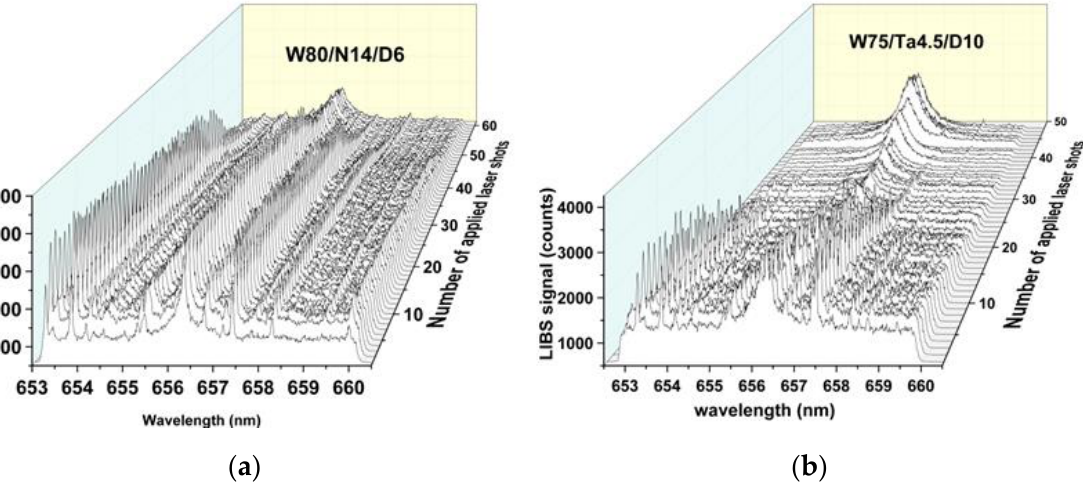
Figure 1. ( a ) sequence of laser shots applied on the W80/N14/D6 sample and ( b ) on the W75/Ta4.5/D10 sample in the spectral region 653 – 660 nm.